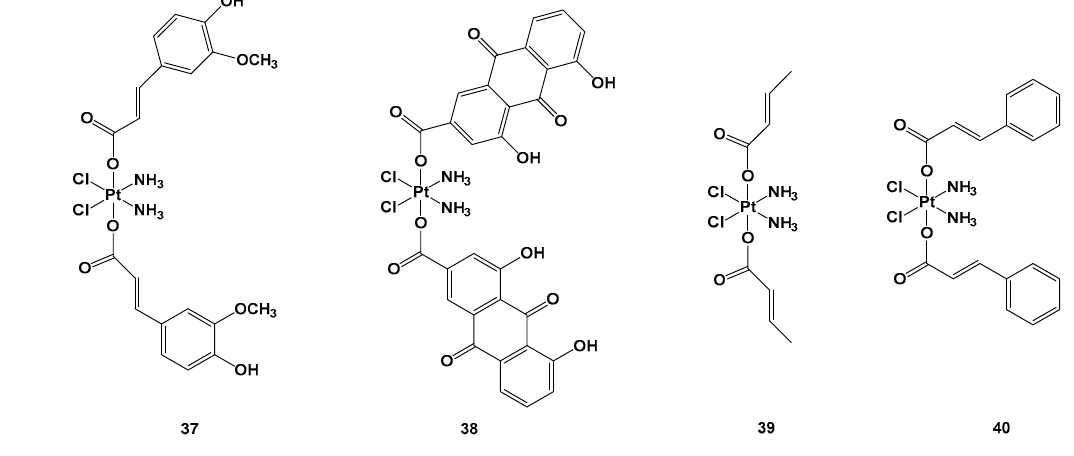
Figure 14. Pt(IV) complexes 36 – 40